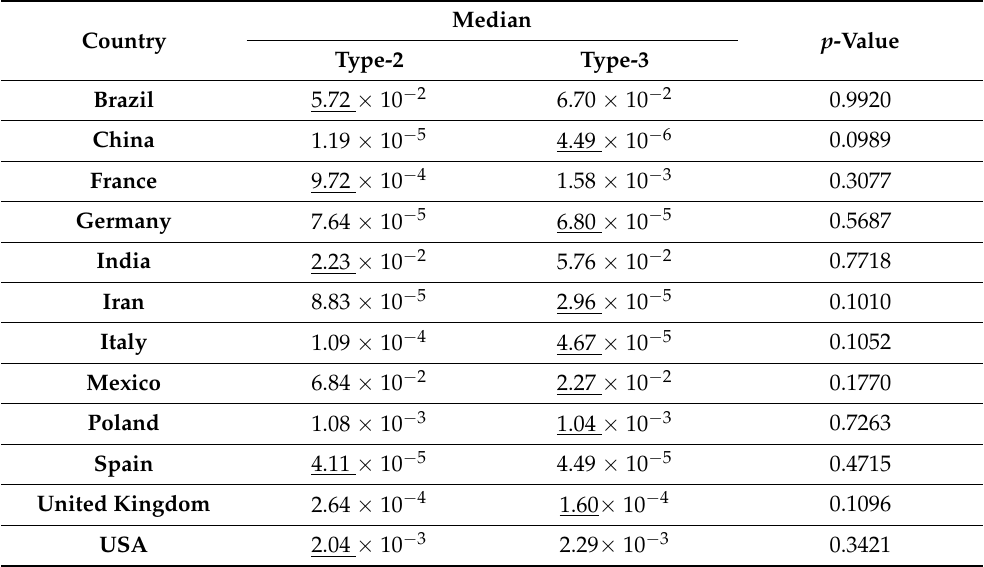
Table 19. Mann–Whitney results (second data period, future